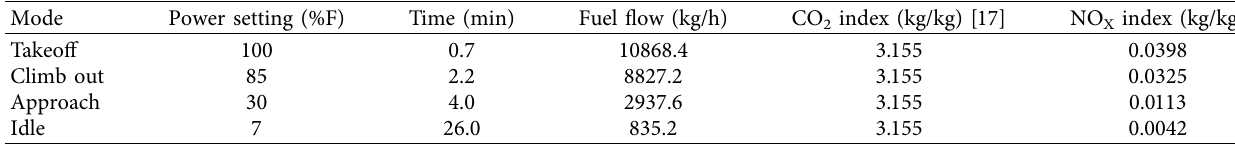
Figure 1: Flow chart of flight cost calculation in the climb. Table 1: Basic emission indices of a PW4077–2PW061